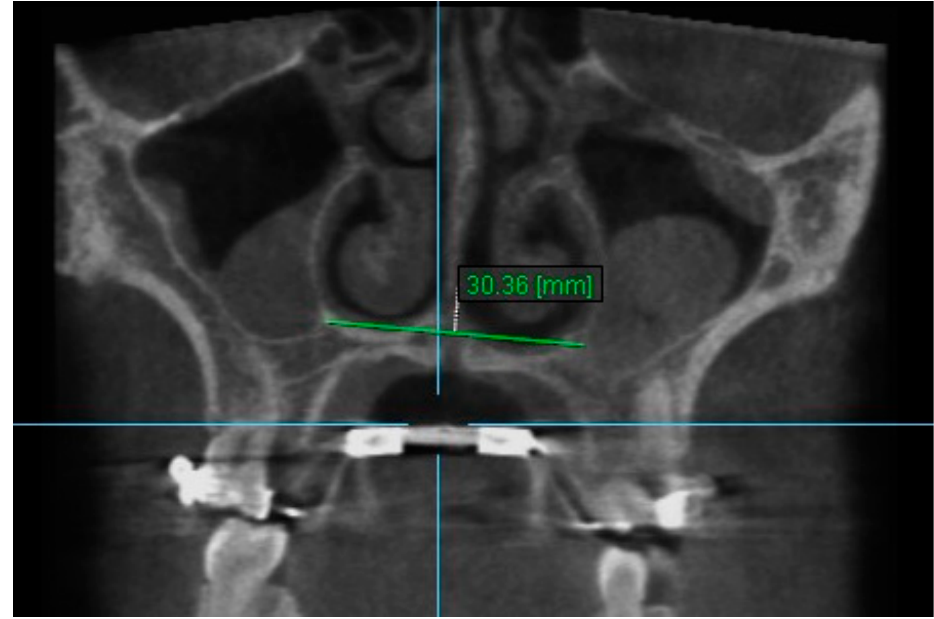
Figure 9. Nasal Floor 7. 8. Nasal Floor 8: The distance between the junction of anatomical floor of nasal cavity and the medial aspect of the floor ipsilateral sinus on coronal slice through the center of root of the second premolar (Figure 10).